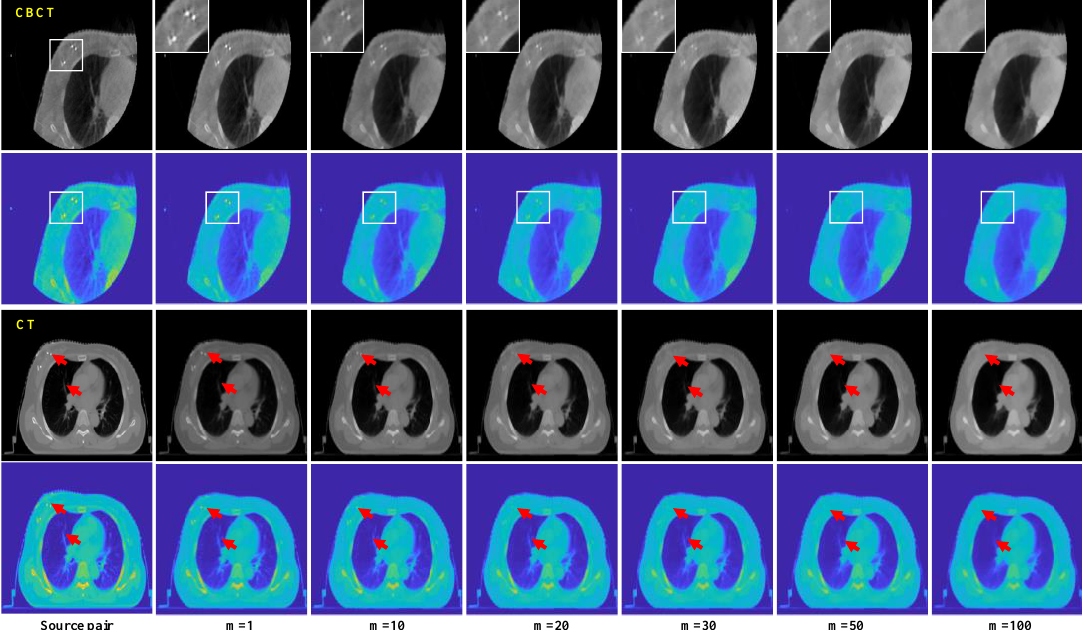
Figure 3. Multi-intensity edge preserving results using MWMC with different m . The first and third lines display the CBCT and CT images, whereas the second and fourth lines display the pseudo-color maps.